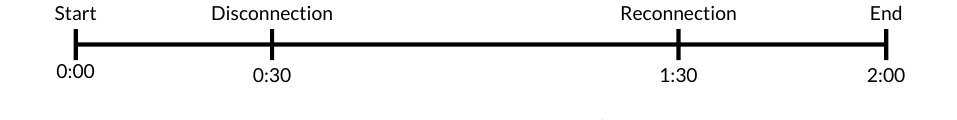
Figure 9. Recovery tests